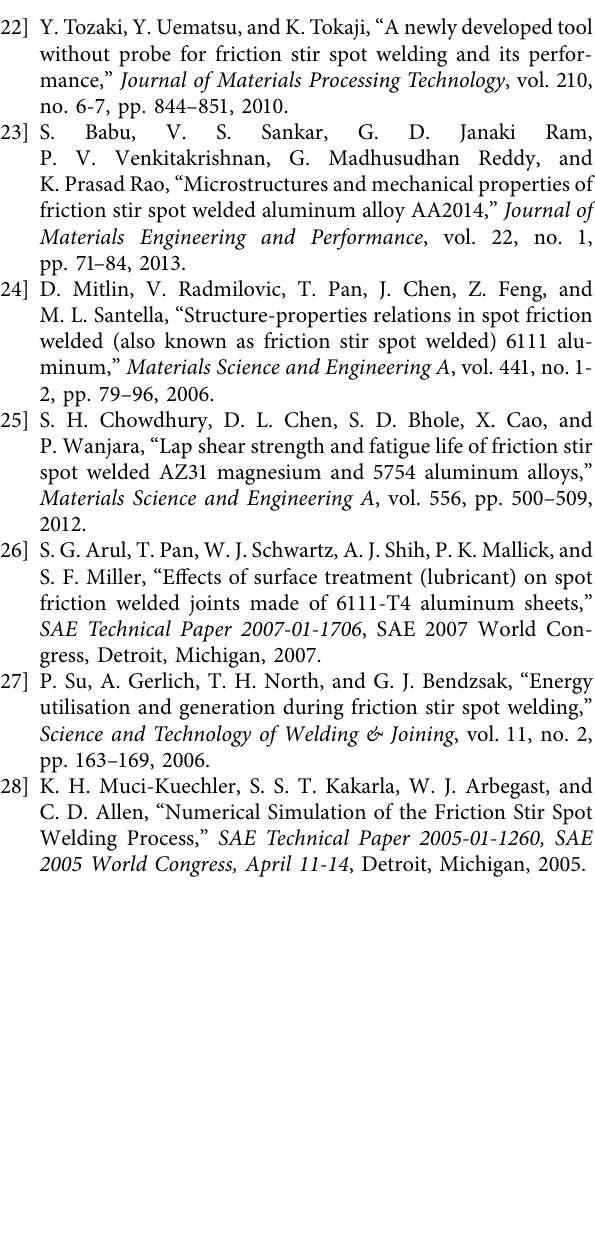
lective laser melted 316L stainless steel: analysis on metal- lurgical and mechanical properties and comparison with wrought 316L stainless steel,” 3D Print Addit Manuf , vol. 1,